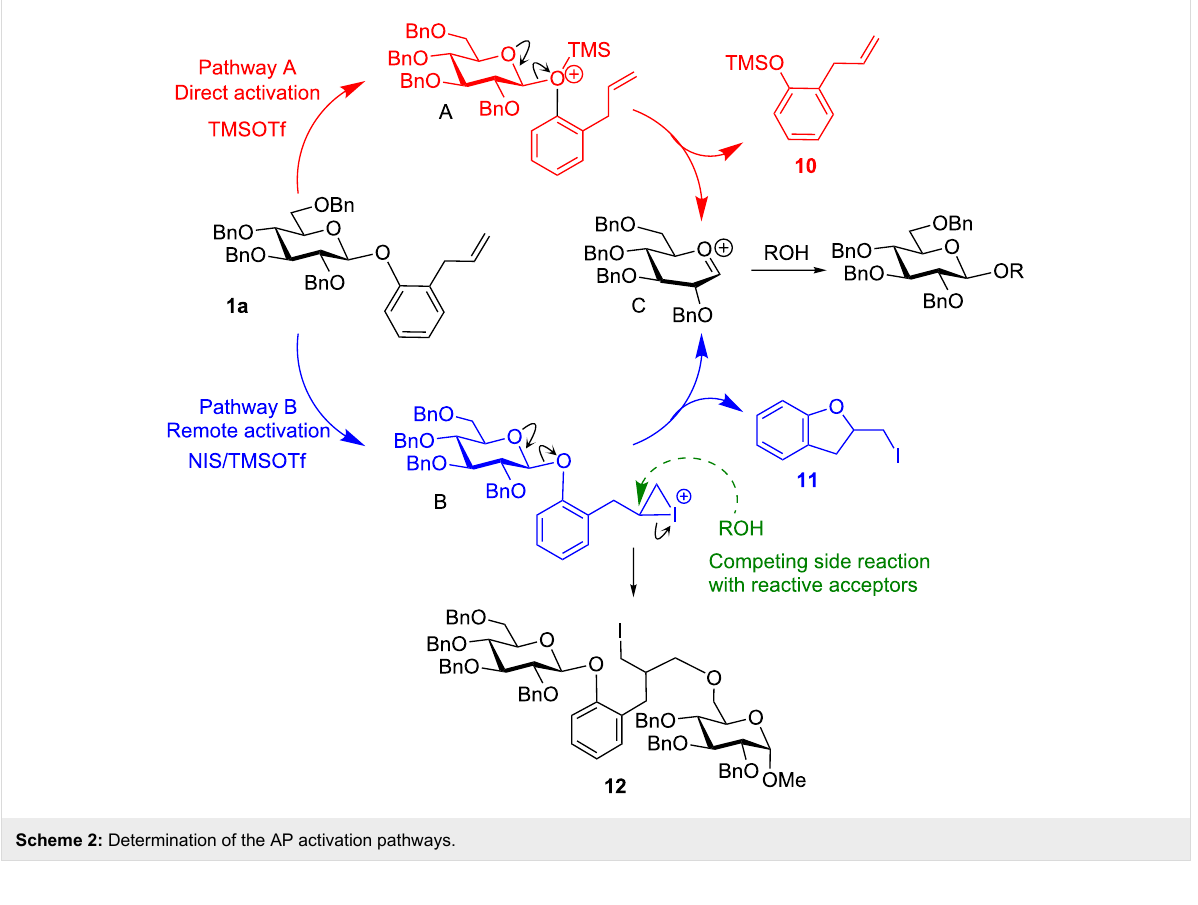
Table 2: AP glycosides as glycosyl donors and acceptors in chemoselective and selective activations.